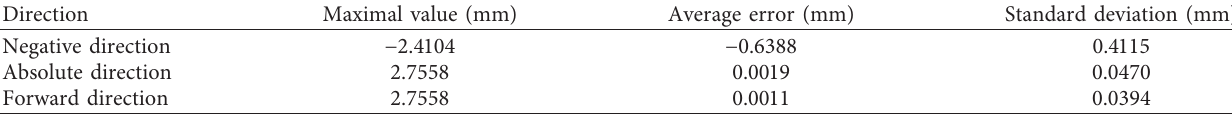
Table 6: Evaluation and analysis of the point cloud by the traditional ADFP method for Figure 16.